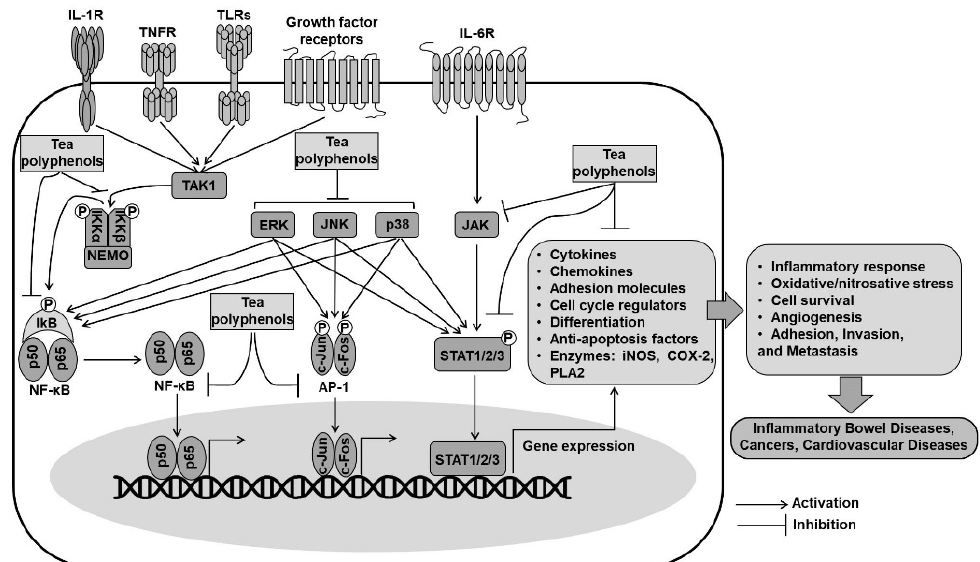
Figure 4. Cytoprotective mechanisms of tea polyphenols via regulation of inflammatory signaling pathways. AP-1, Activator protein 1; NF- κ B, Nuclear factor kappa B; NEMO, NF-kappa-B essential modulator; STAT, Signal transducer and activator of transcription; ERK, Extracellular signal-regulated kinase; JNK, c-Jun N-terminal kinase; JAK, Janus kinases; IKK α / β , Inhibitor of nuclear factor Kappa-B kinase subunit alpha/beta; I κ B, Inhibitor of κ B; TAK1, Transforming growth factor- β -activated kinase 1; TLRs, Toll-like receptors; TNFR, Tumor necrosis factor receptor; IL-1R, Interleukin-1 receptor; IL-6R, Interleukin-6